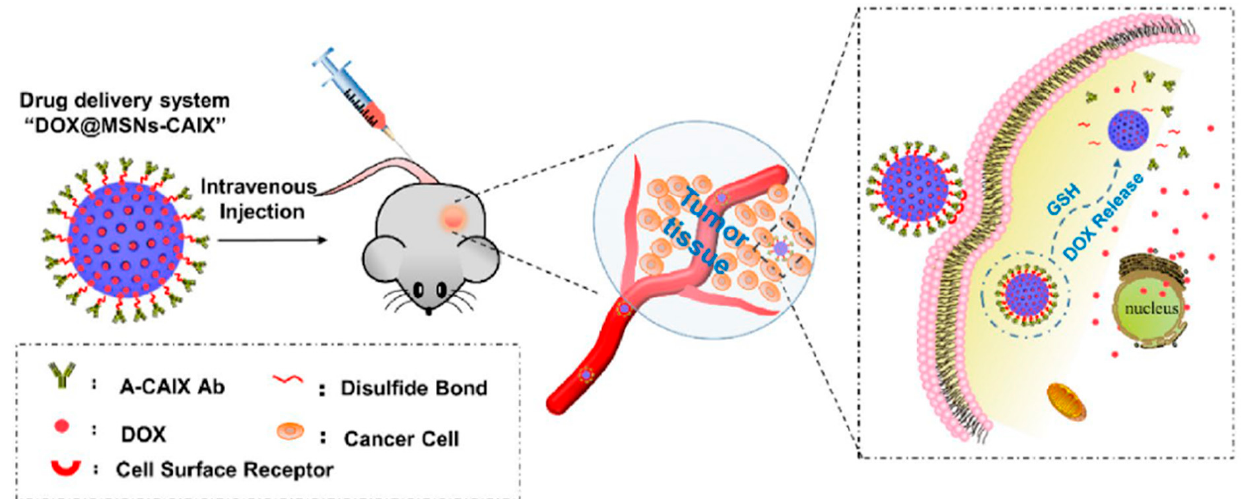
Figure 4. The A-CAIX Ab targeted mesoporous silica nanoparticles utilized as a redox-responsive drug delivery system. Reproduced from Chen et al. [81], Open Access. drug delivery system. Reproduced from Chen et al. [81], Open